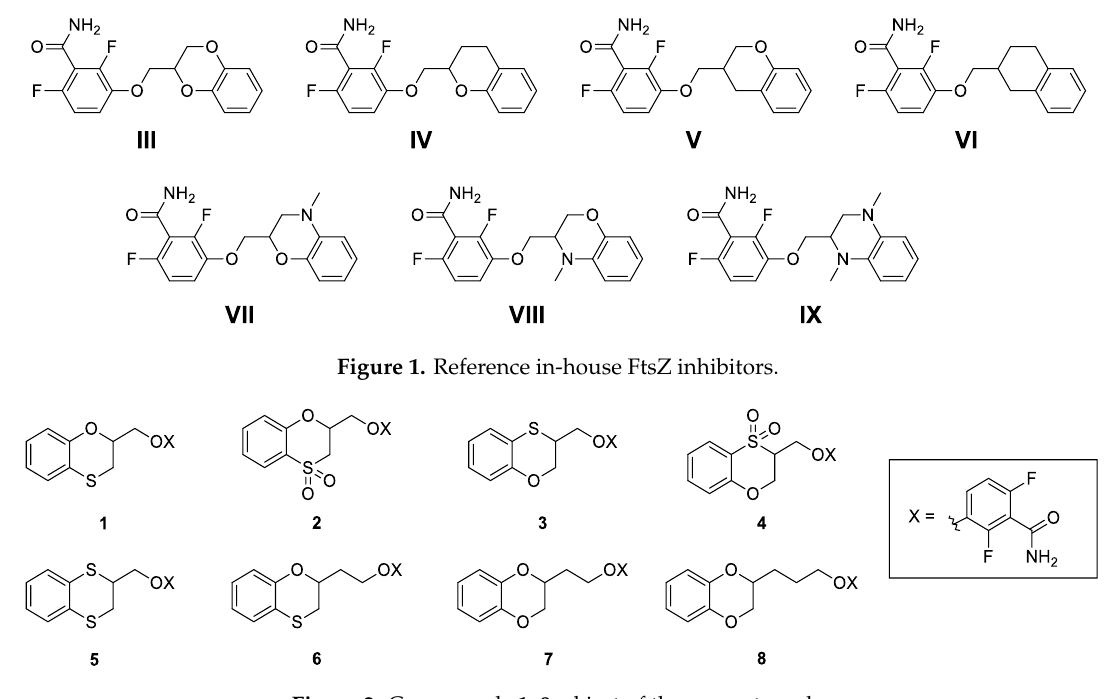
Figure 2. Compounds 1–8 , object of the present work.